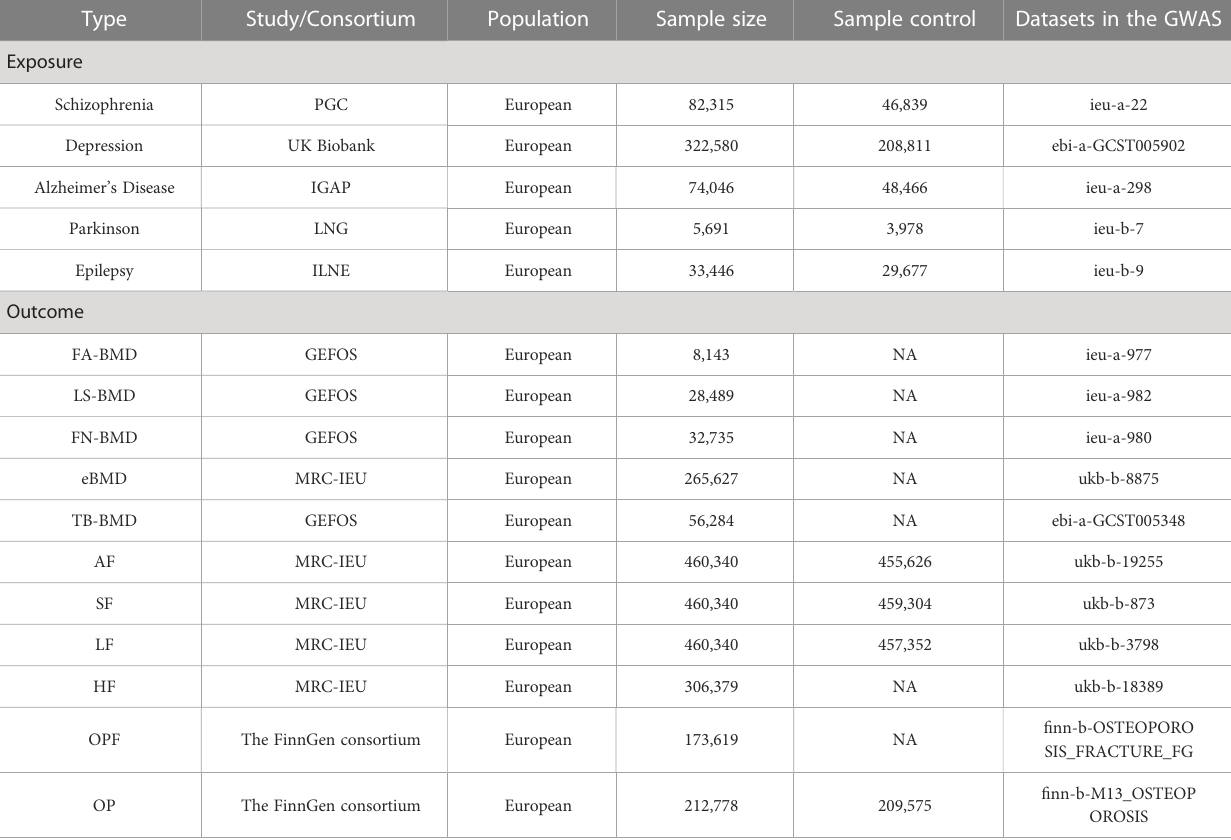
TABLE 1 The detailed data information of the Mendelian randomization study on the association of MDs with the risk of OP.